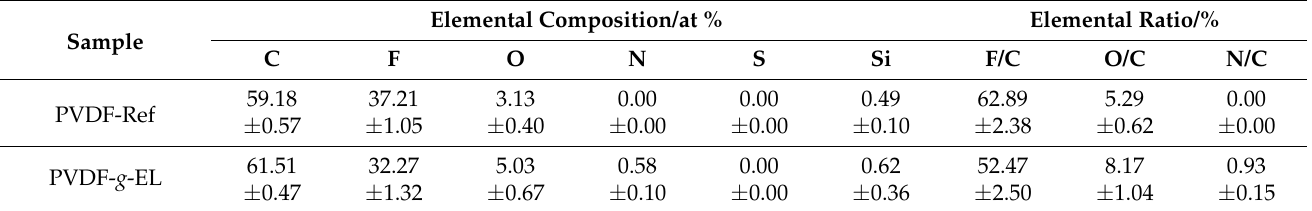
Figure 1. Evaluation of V max (I-optimal RSM design). Contour plots for enzyme concentration and irradiation dose at ( a ) 1 min; ( b ) 10 min; and ( c ) 3D surface plot at 5 min; as well as ( d ) progress curves of optimized PVDF- g -EL and pristine PVDF-Ref ( n = 5). Table 4. XPS measurement data of pristine PVDF-Ref and enzyme-loaded PVDF- g -EL ( n =